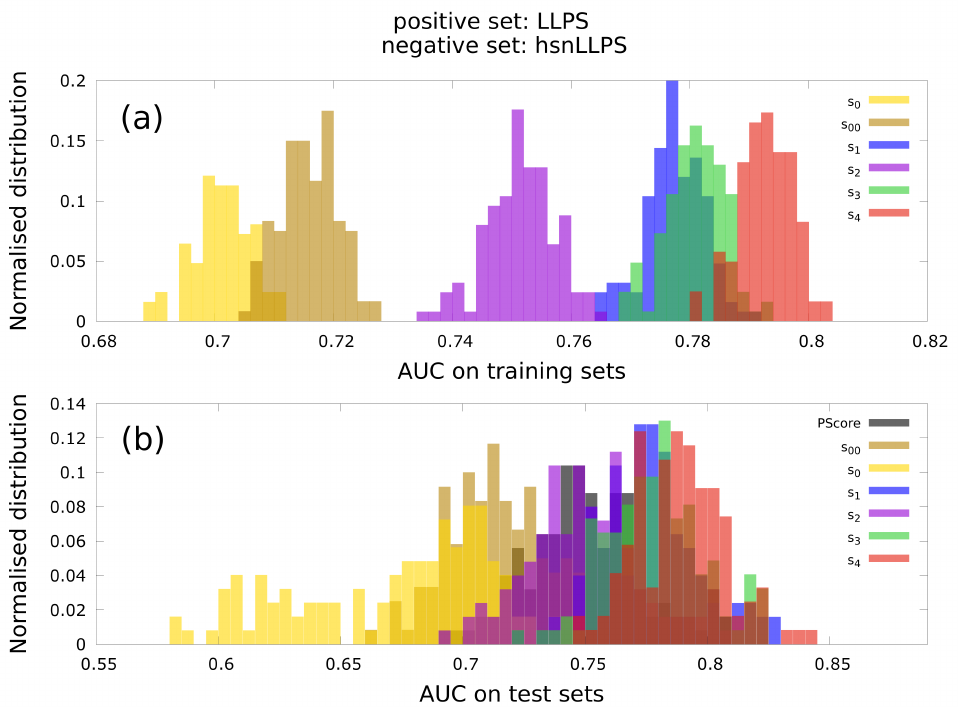
Figure 3. Normalised distributions for the values of AUC on the ( a ) training set and the ( b ) test set as obtained from the cross validation procedure. LLPS is the positive set and hsnLLPS is the negative set. The AUC values for PScore shown here were obtained on the test sets of cross